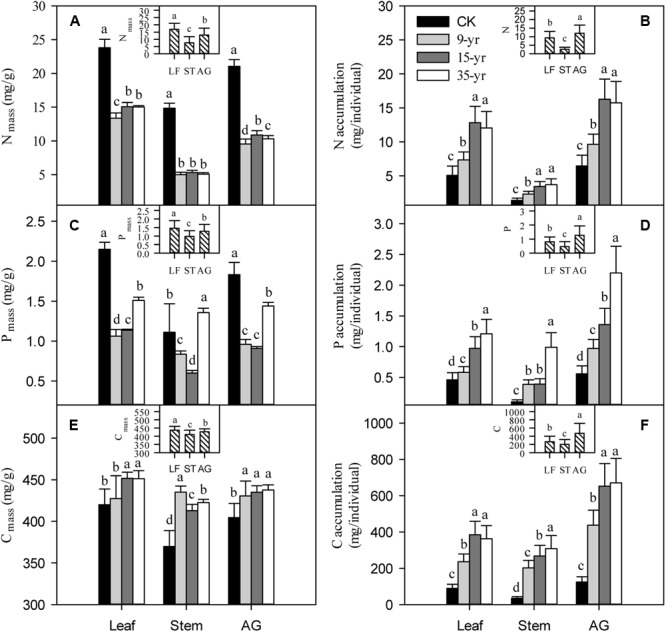
Effects of grazing exclusion on C, N, and P concentrations (A,C,E, respectively) and accumulations (B,D,F, respectively) in leaves, stems, and the aboveground portions of Leymus chinensis individuals following grazing exclusion (mean ± SD). CK is open grazing; 9-yr is 9-year grazing exclusion; 15-yr is 15-year grazing exclusion; 35-yr is 35-year grazing exclusion; AG is aboveground portion; LF is leaf; ST is stem. Different superscripts denote significant differences (P < 0.05).